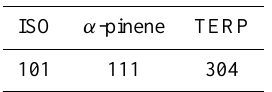
Table 3. VOC emissions for the case study. Emissions dur- ing the day follow a sinusoid with the maximum emission flux (µgm − 2 h − 1 ) as